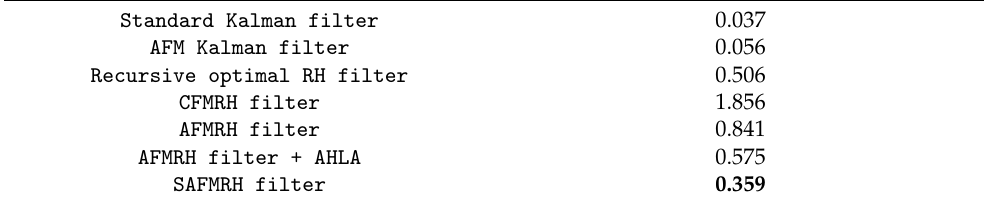
Table 2. Average computation time